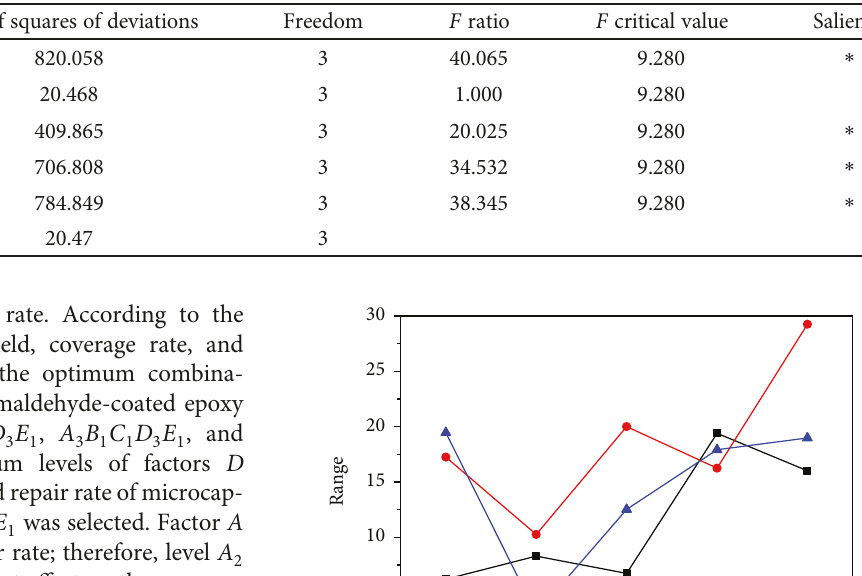
Table 11: Remarkable analysis of repair rates of microcapsules.